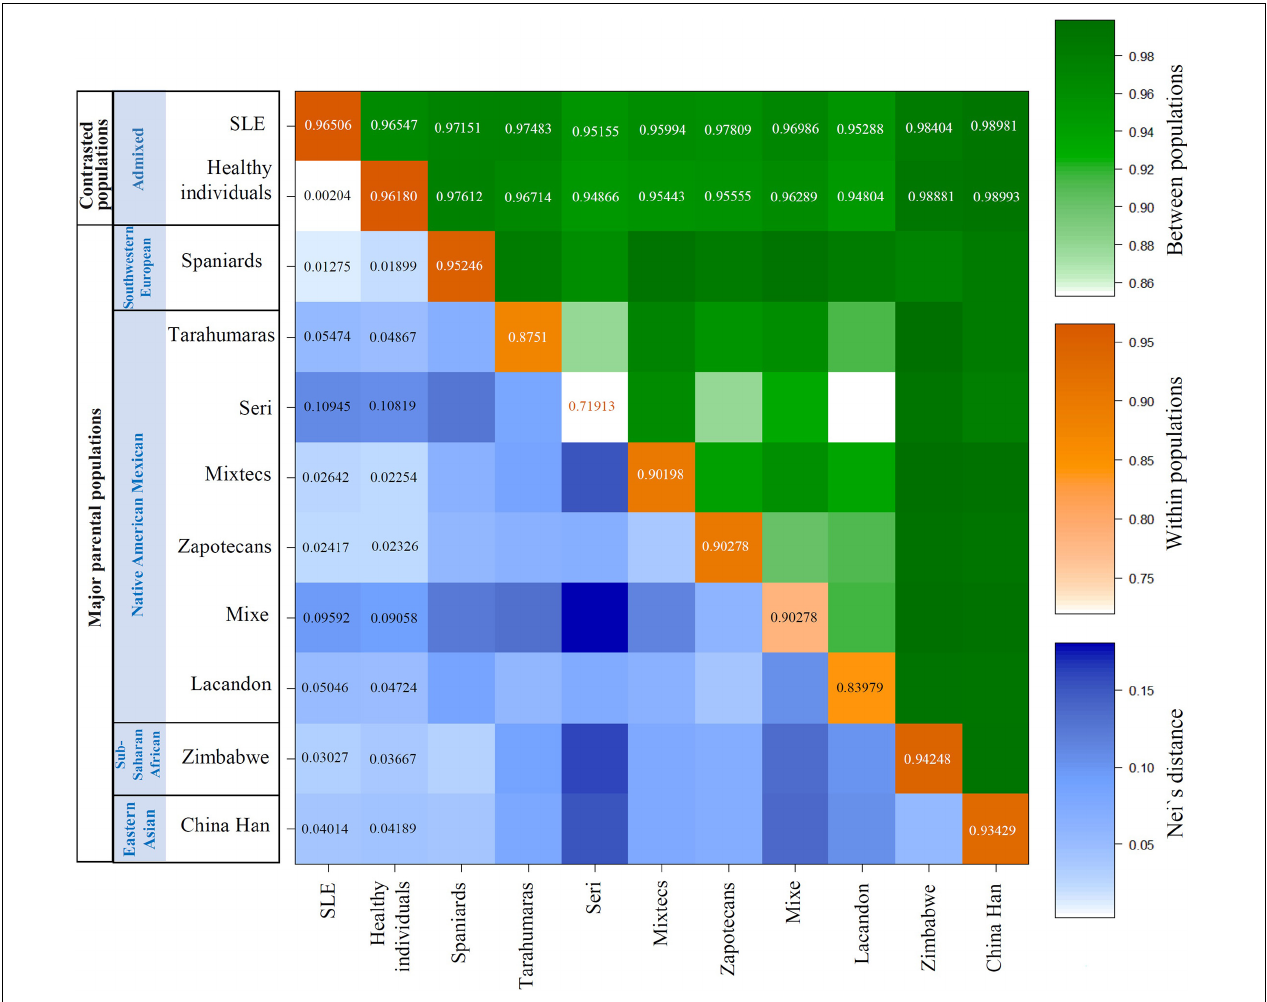
FIGURE 2 | Genetic distances revealed differences in Mexican Native American and Southwestern European ancestry between the SLE and healthy individuals. In this matrix, we represent three different color scales, the average number of pairwise differences ( π ) between populations. Orange on diagonal: π within populations; Green above diagonal: π xy between pairs of populations Blue below diagonal: net number of nucleotide differences between populations (Nei’s distance). The interpretation is the same for the three scales; it is shown in the right color bars. To > value > genetic distance. To > intensity color > genetic distance.